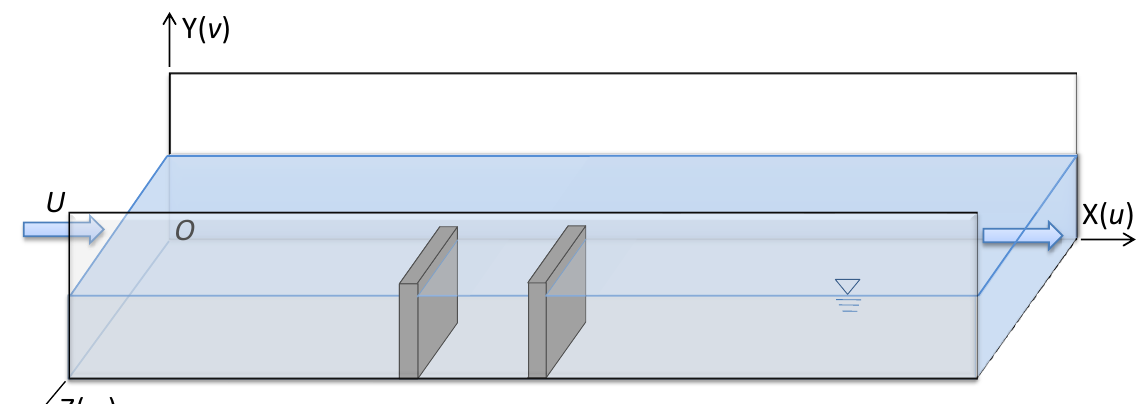
Figure 1. Ipsilateral and orthogonal NDSDs in flume.